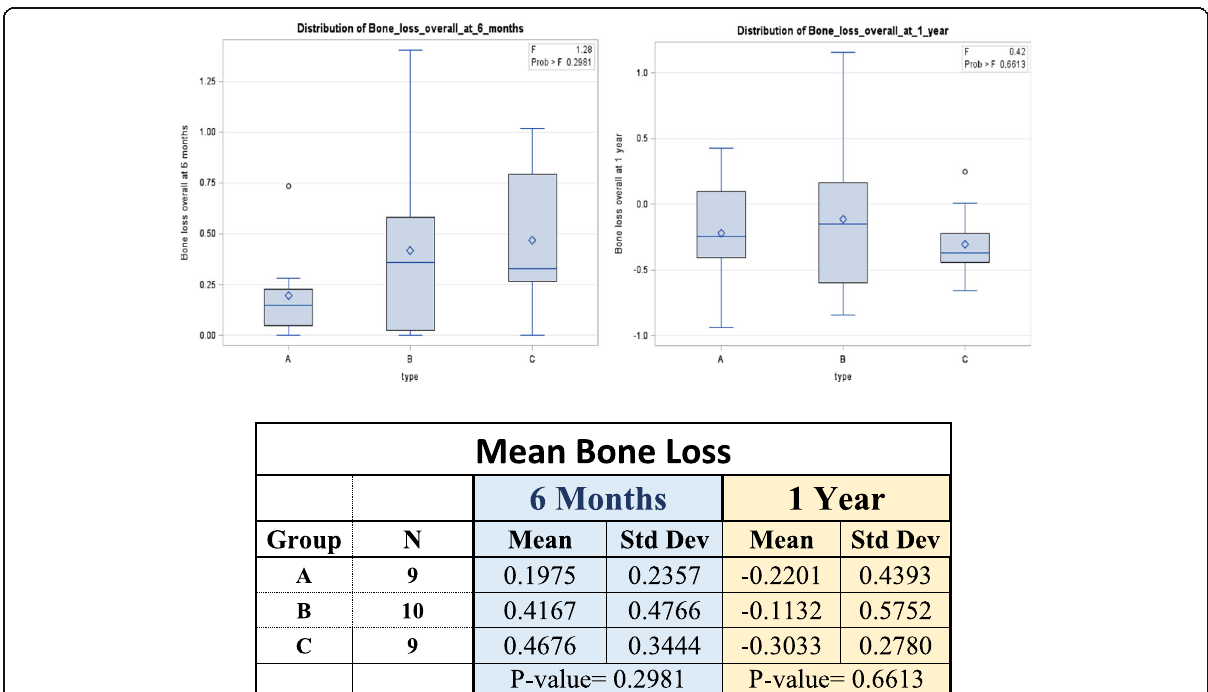
Fig. 3 Mean bone loss at 6 months and 1 year. Mean bone loss distribution charts at 6 months and 1 year present no statistically significant difference. p value at 6 months was 0.2981 and at 1 year